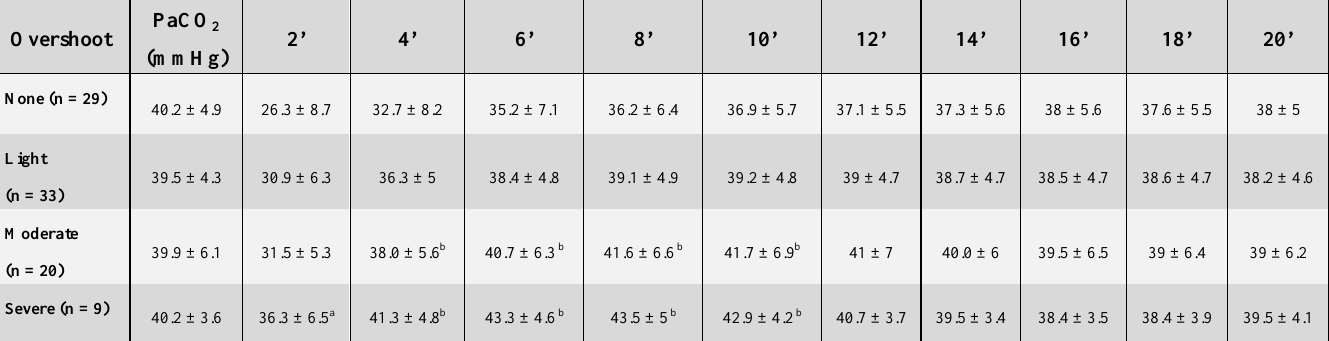
Table 4. Mean baseline PaCO mm Hg) in patients with and without several degrees of